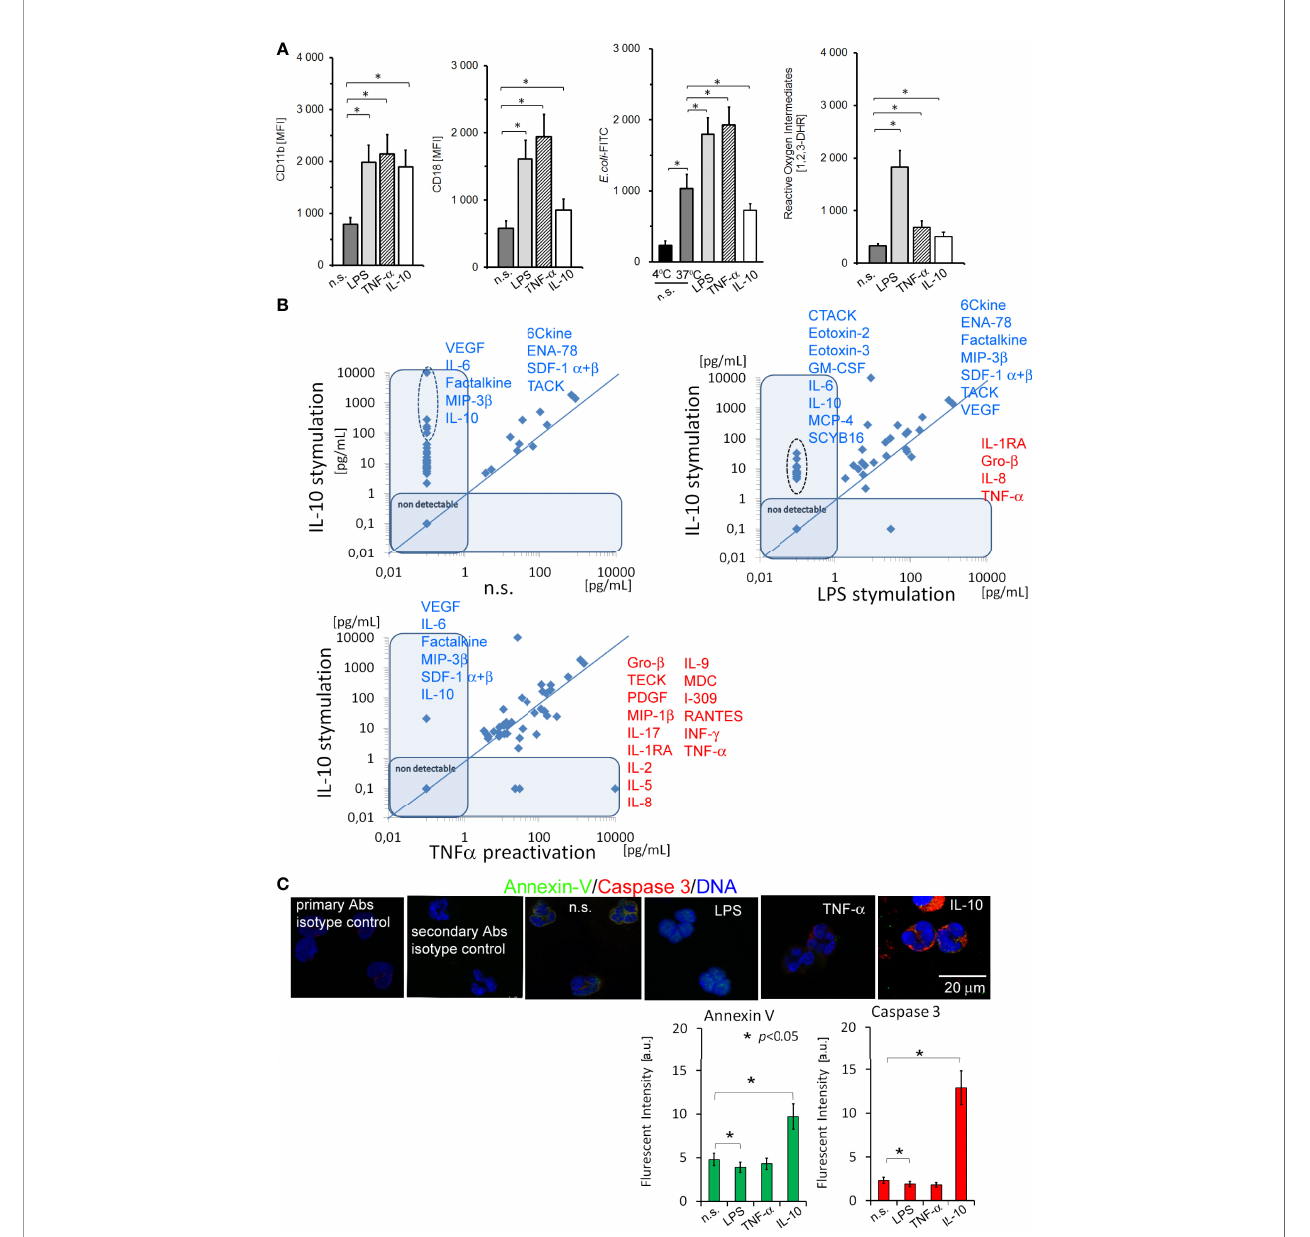
FIGURE 1 | The analysis of adhesive molecule expression, phagocytosis, and ROI production, and the pro fi le of cytokines/chemokines and growth factors released by neutrophils stimulated by IL-10 revealed their ability to synthesize a number of pleiotropic mediators, even though neutrophils were apoptotic. (A) The analysis of CD11b/CD18, E.coli phagocytosis, and ROI production by non-, LPS-, TNF- a -, or IL-10-stimulated neutrophils. The bars represent the MFI ± SD calculated from four independent experiments. (B) The comparison of cytokine/chemokine/growth factors pro fi le released by neutrophils stimulated by IL-10 to non-stimulated and LPS or TNF- a − stimulated neutrophils. The blue line determines the border between up- and downregulated factors, each point represents the mean calculated from four independent experiments. (C) ICC double labelling for caspase-3 (red pseudocolor) and Annexin-V (green). The bars represent average fl uorescence intensity ± SD calculated from four independent experiments, using at least 100 single cells for each